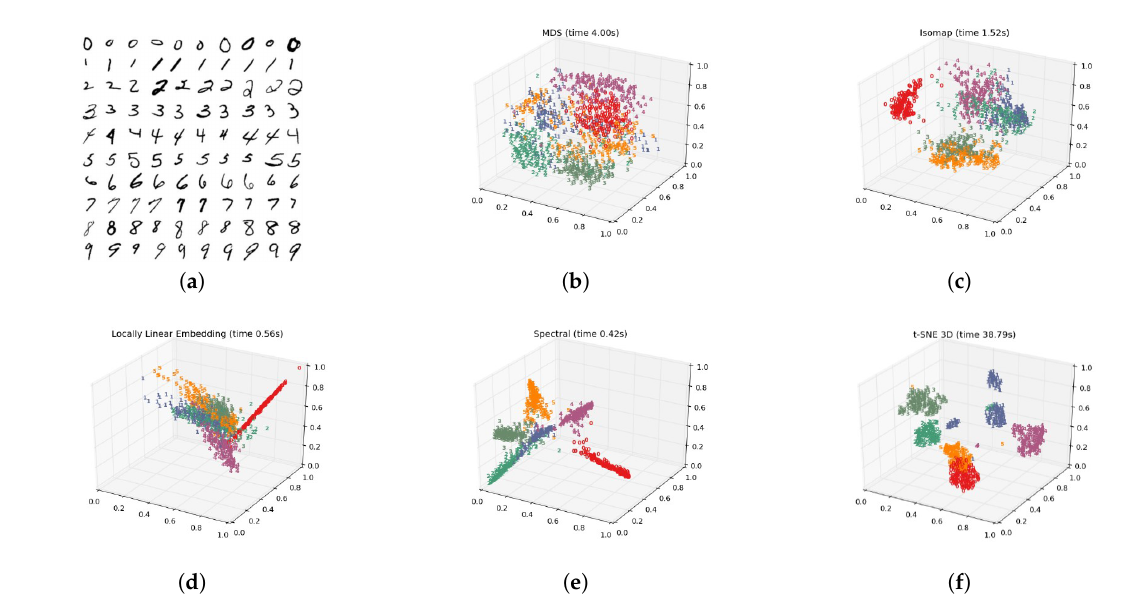
Figure 4. Different manifold visualization on Mnist dataset. ( a ) Original image sample. ( b ) MDS. ( c ) Isomap. ( d ) LLE. ( e ) SE. ( f )